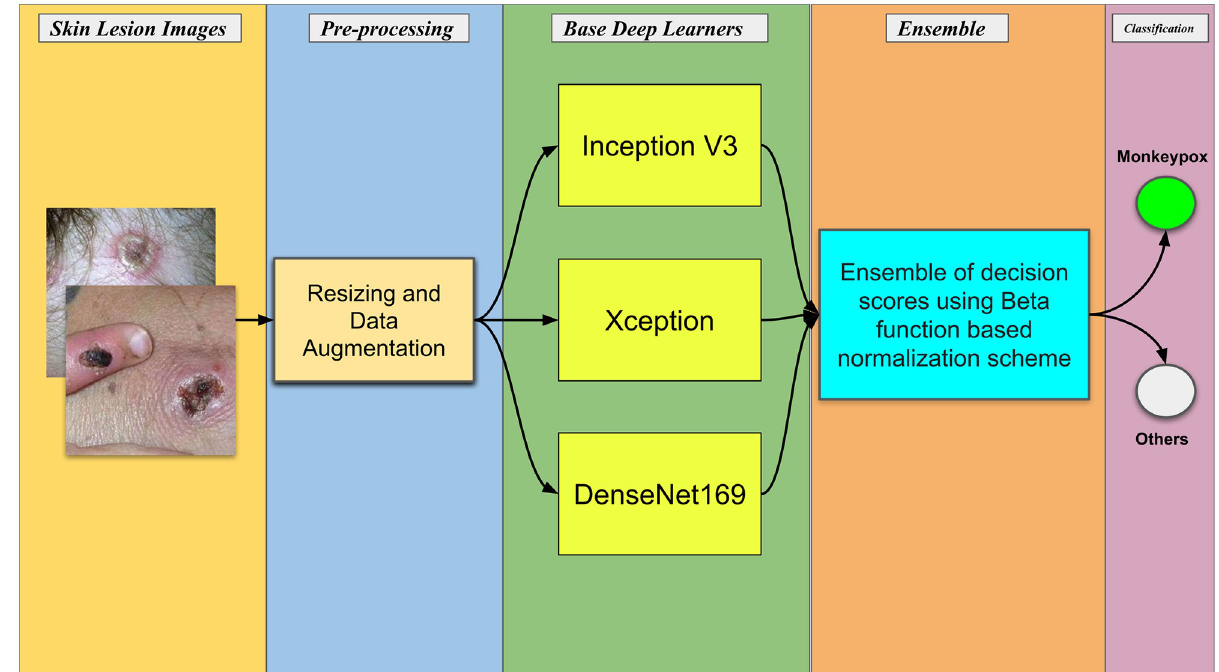
Fig 1. The overall pipeline of the present work for Monkeypox detection from skin lesion images.